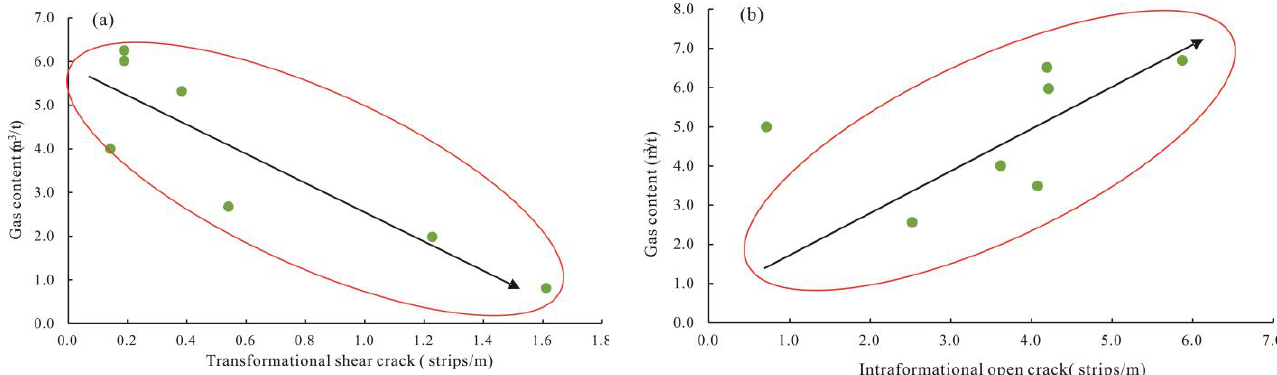
Figure 14. A crossplot of the well gas content and different cracks in the Luzhou area. ( a ) Intersection diagram of the gas content and transformational shear cracks. The gas content decreases with the increase of transformational shear cracks; ( b ) intersection diagram of the gas content and intraformational open cracks. The gas content increases with the increase of intraformational open cracks.